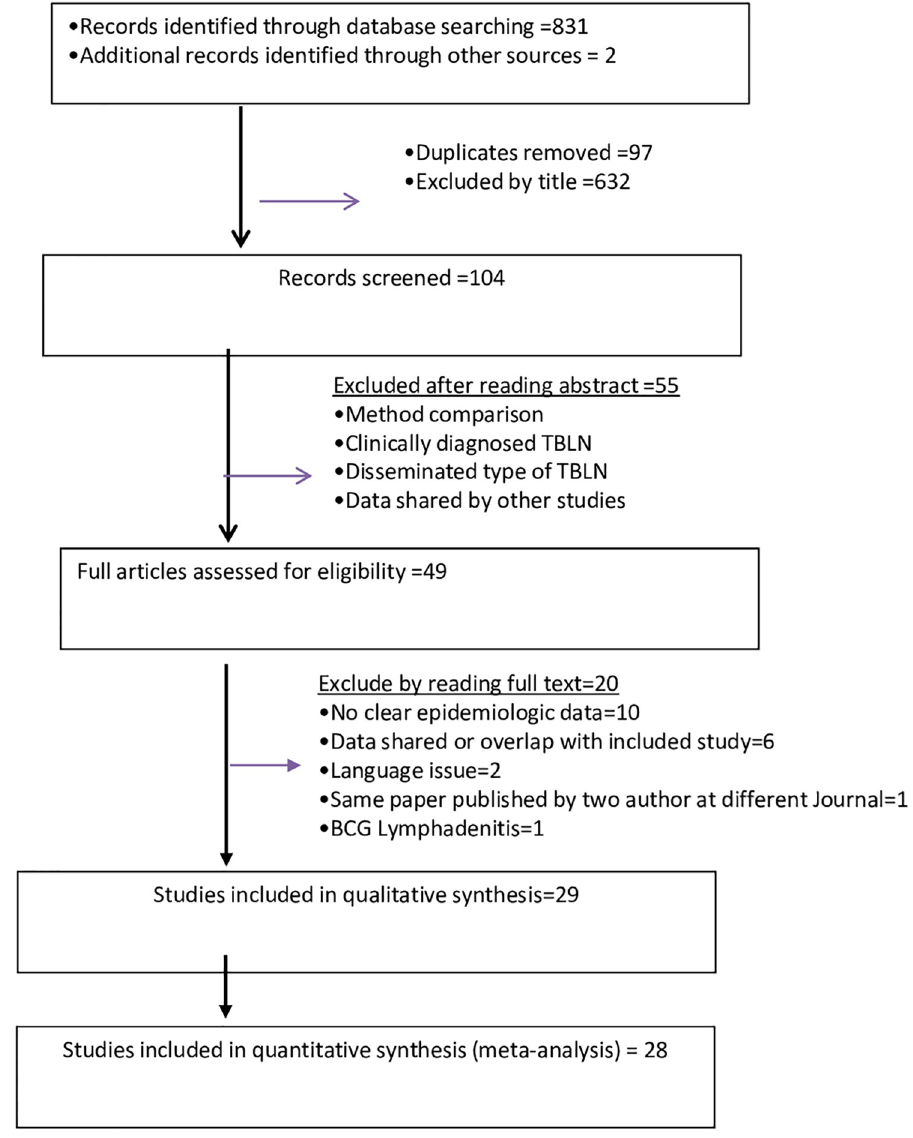
Fig 1. PRISMA flow diagram of literature selection, Africa, 2018. Cervical TBLN is the most prevalent form and ranged from 47% [45] to 98% [50]. The sub- (85%) (Fig 3A). On the other hand, Bem (1997) reported low prevalence of matted type TBLN,17% [50], while other studies reported higher than 50% prevalence of the matted types [16, 38, 41, 51, 61] (Fig 3B). Three sub-group analyses were done on proportion of females among TBLN subjects; Ethi- opia in one group, southern and western African articles in the second group and that of northern and other eastern African countries in a third group. Pooled prevalence of female gender among north and eastern African studies, excluding Ethiopia, reported the lowest